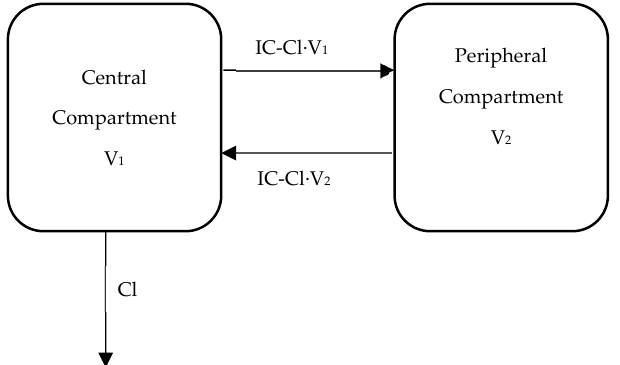
Figure 3. Two-compartment pharmacokinetic model. Cl: apparent clearance (L / h / m 2 )); V 1 : volume of the central compartment (L / m 2 ); IC-Cl: inter-compartmental clearance (L / h / m 2 ); and V 2 : volume of the peripheral compartment (L / m 2 ).